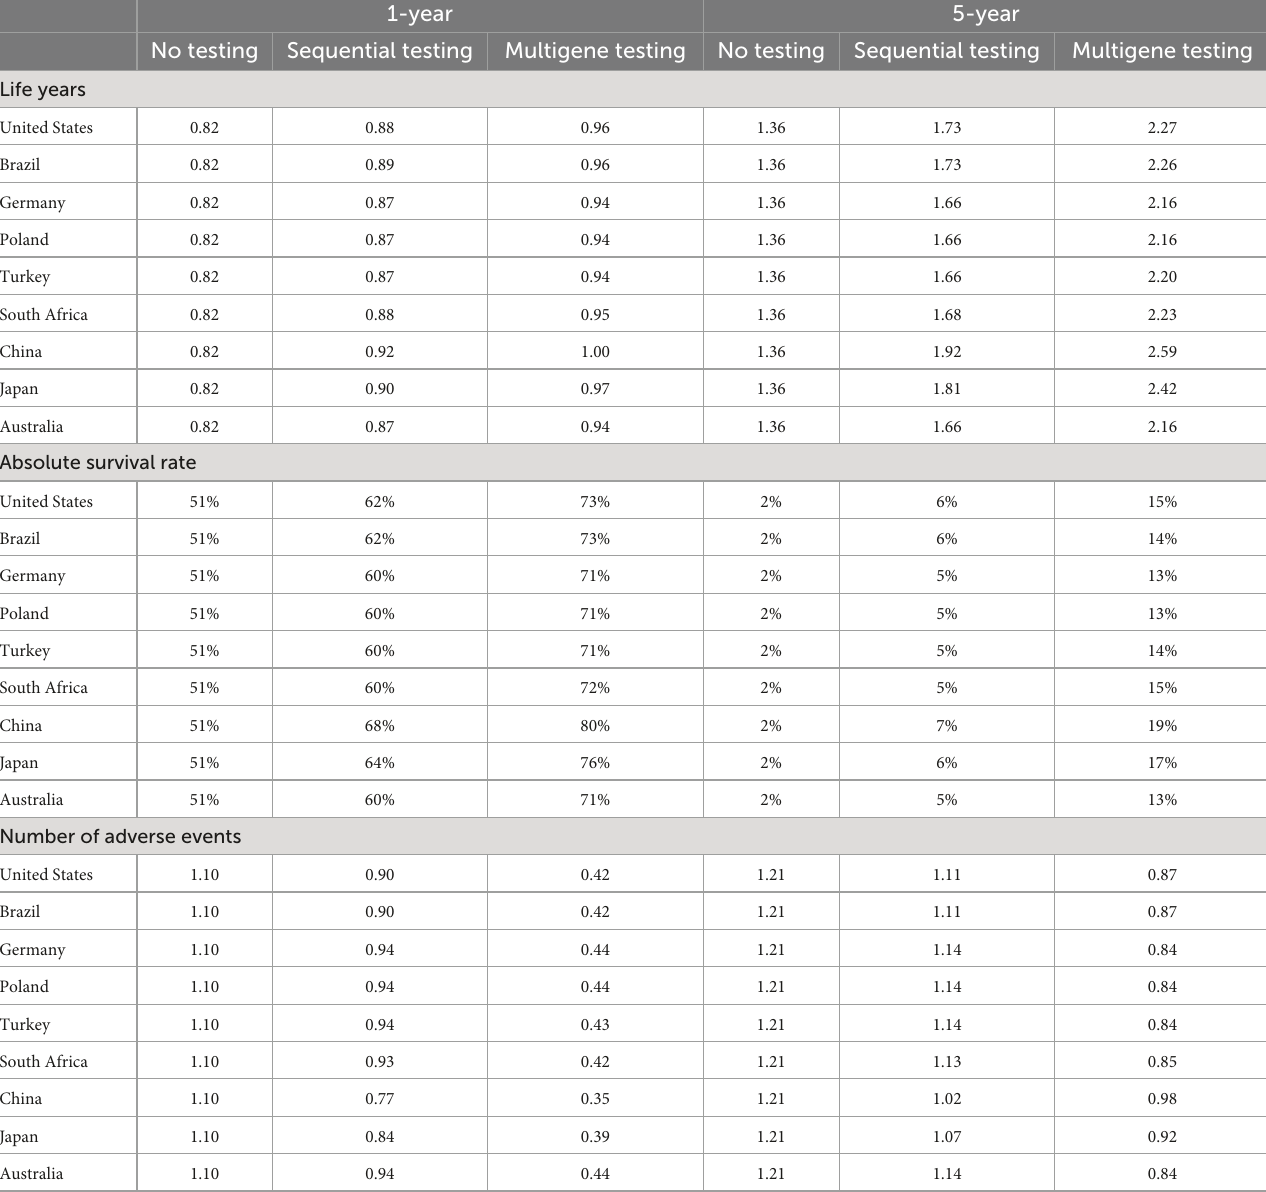
TABLE 1 Health-related outcome measures per